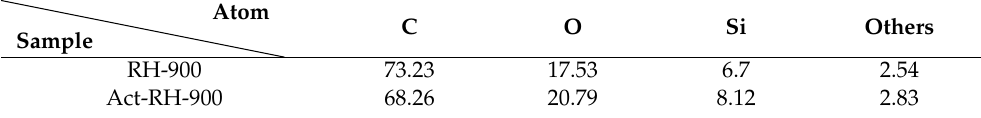
Table 1. Composition of RH-900 and Act-RH-900 samples (atomic